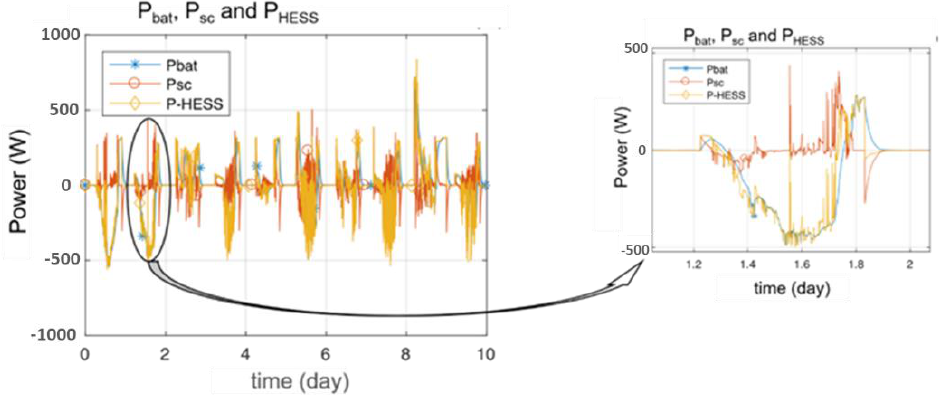
Figure 11. Total unfiltered HESS power, filtered SC, and battery power.